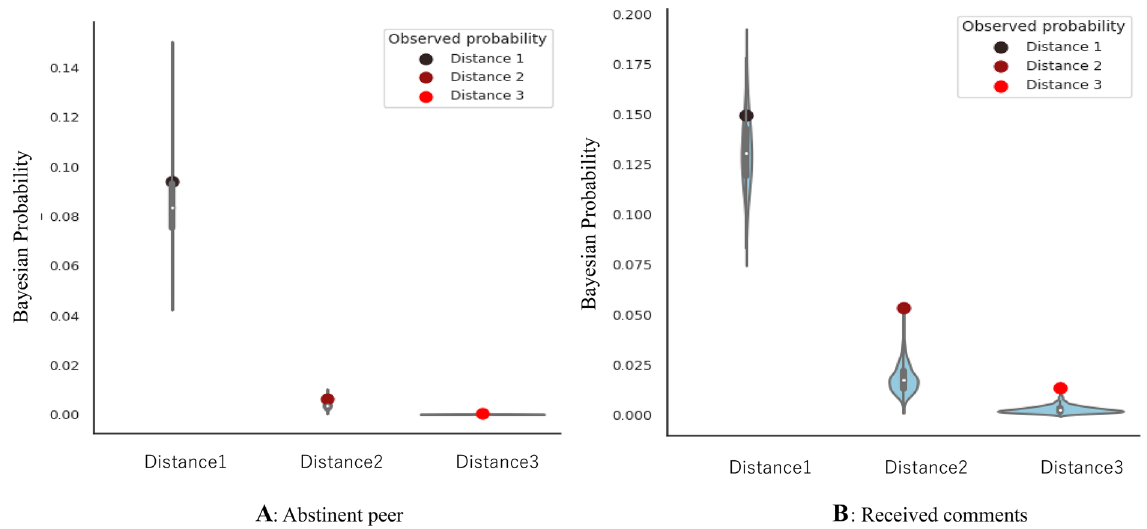
Figure 5. Social contagion of gambling abstinence via abstinent peers and received comments in online self- help forums. ( A ) Social contagion of gambling abstinence via abstinent peers. ( B ). Social contagion of gambling abstinence via received comments. The red dots are the observed probabilities, and the blue shapes are kernel density estimations of the underlying distribution of simulation results. The simulation results of A and B were obtained from 1000